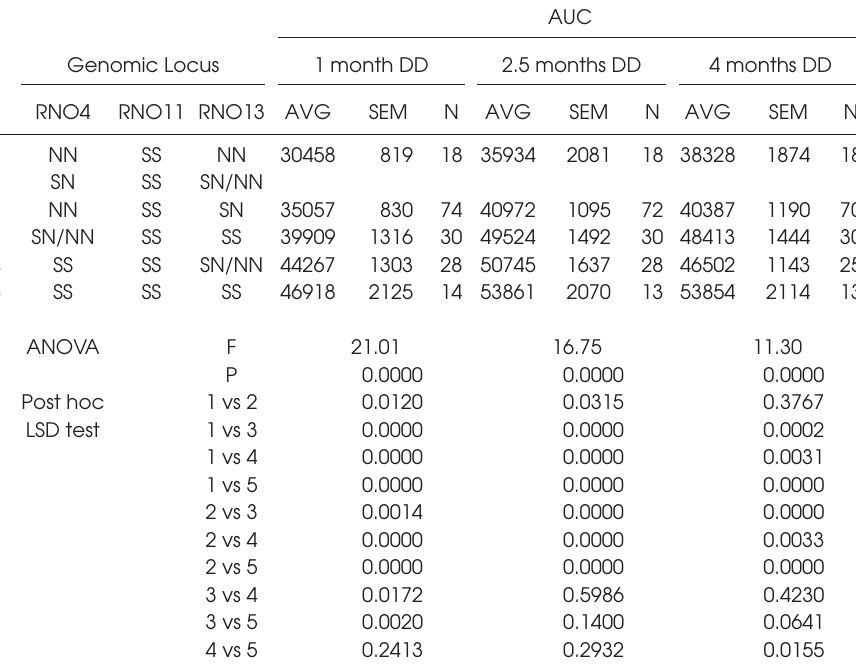
Table 2. Cosegregation analysis for representative microsatellite markers within the genomic loci on RNO4, -11 and -13, based on F2 intercross between CDs/y and